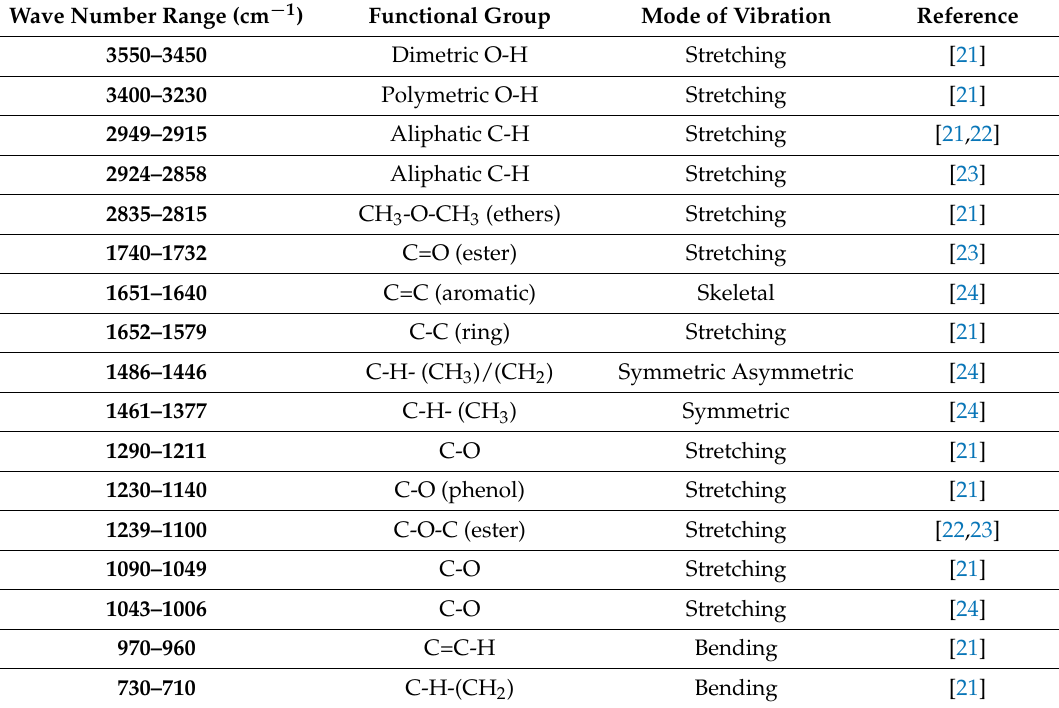
Table 3. Main functional groups of emulsifiers, co-surfactants and liquefaction